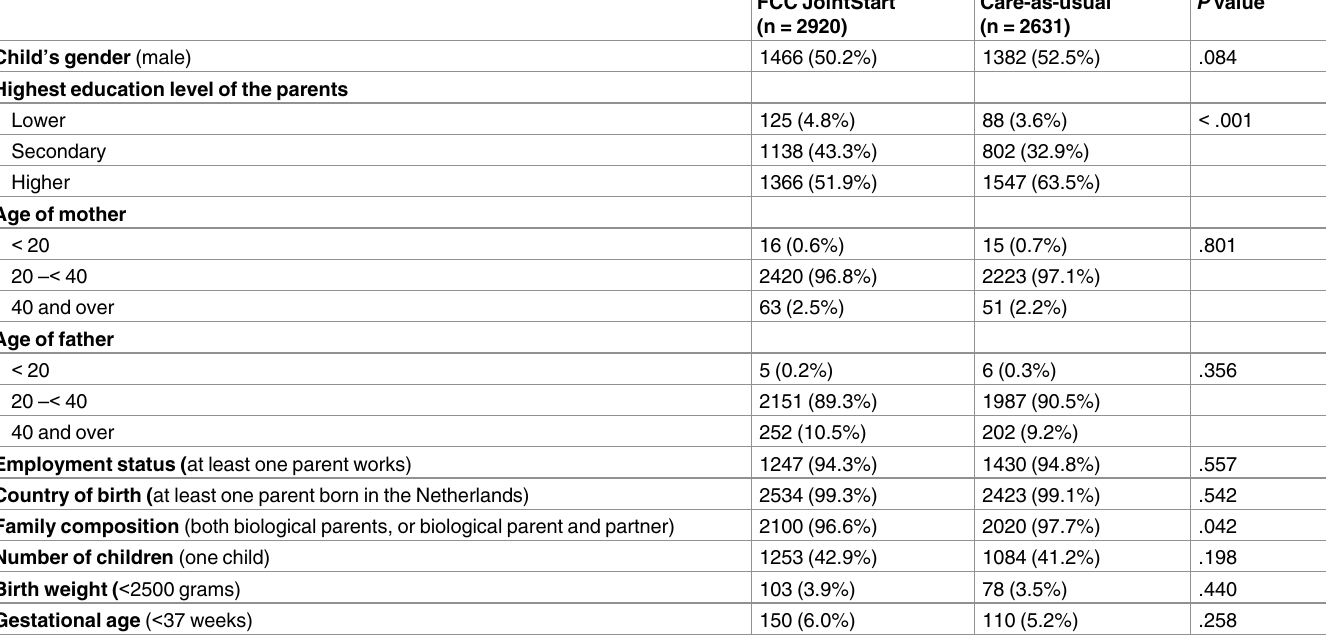
Table 2. Characteristics of participants in the Family-centered care approach (FCC-JointStart) and Care-as-usual